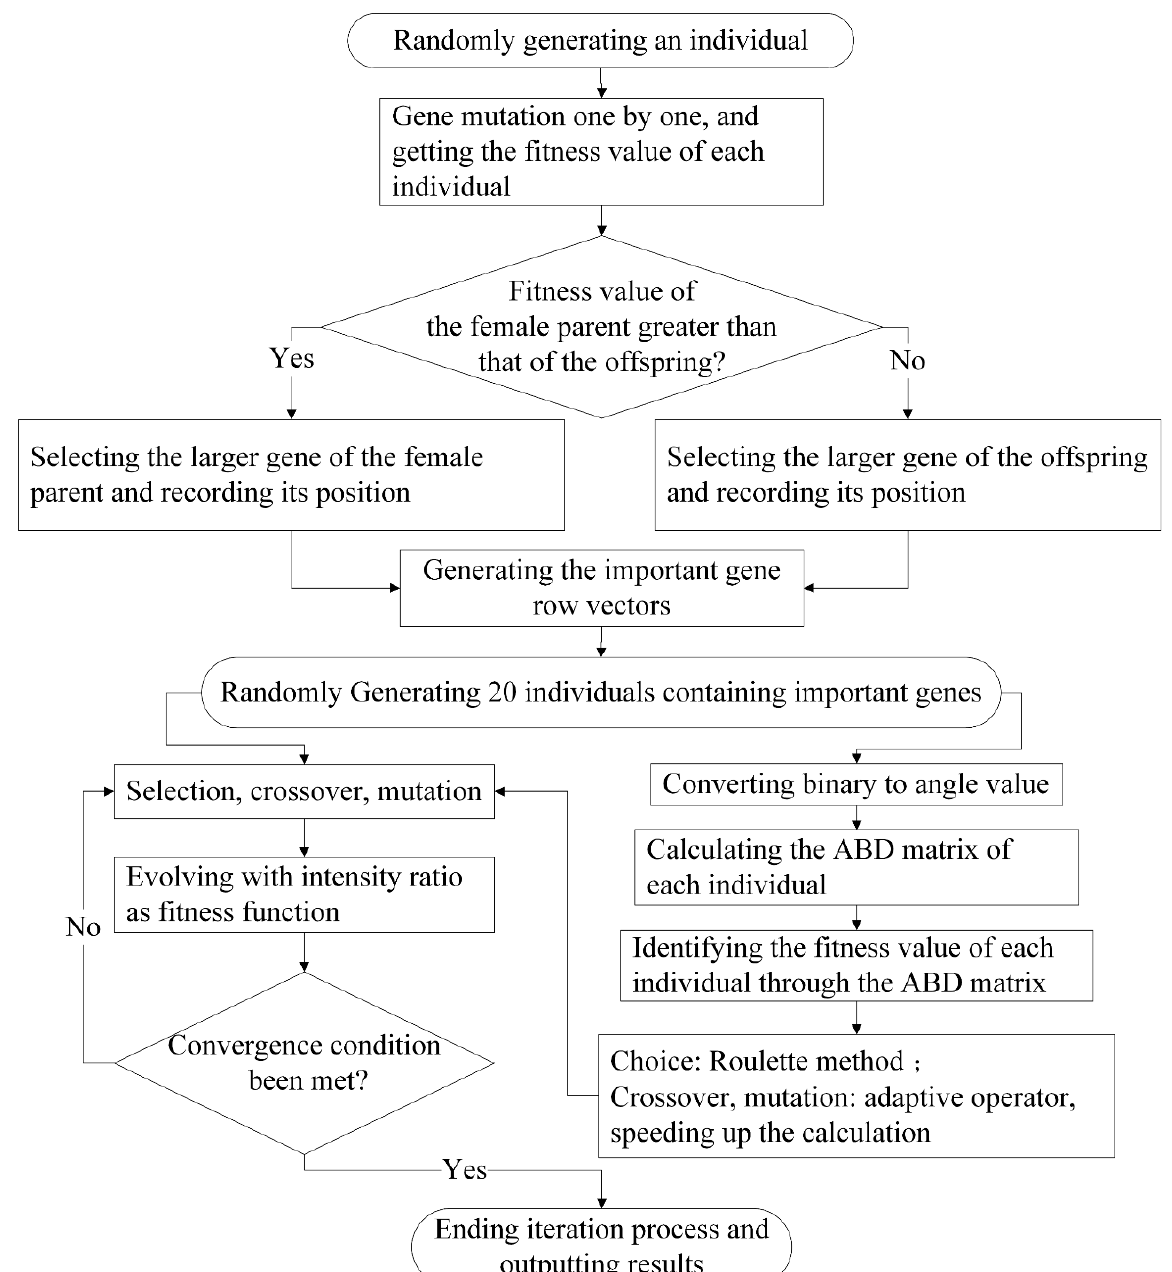
Figure 4. Flow chart of the IGA.